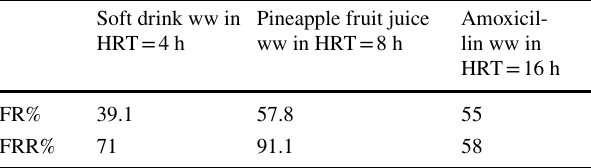
Table 5 The results of FRR% and FR% during long-term filtration in the MF membrane at constant pressure of 15 psi for three types of wastewater